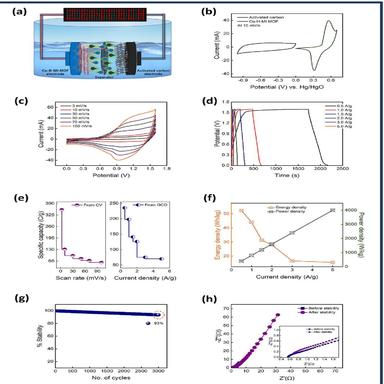
(a) Cu-B-MI-MOF //AC asymmetric device's illustration (b) CV curves of Cu-B-MI-MOF and AC (c) CV of the Cu-B-MI-MOF//AC device (d) Galvanostatic charge/discharge curves at distinct current densities (e) Plot of extracted specific capacities from CV profile and charge–discharge profile (f) Plot depicting the energy and power density of the hybrid device (g) Capacity retention curve of Cu-B-MI-MOF//AC after three thousand GCD cycles (h) Electro-impedance spectroscopy spectrum of Cu-B-MI-MOF//AC.